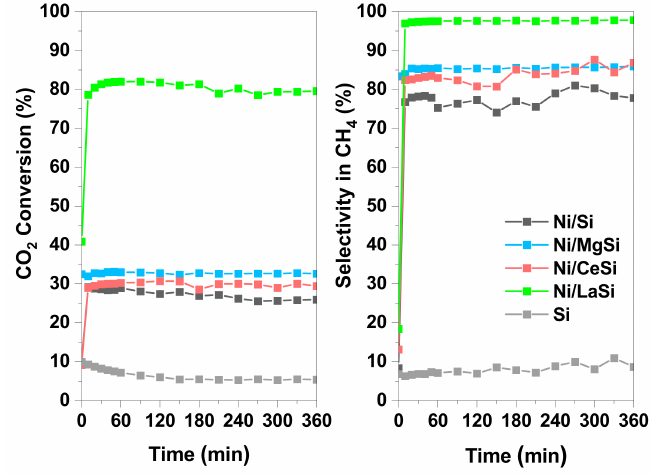
Figure 8. CO 2 conversion and CH 4 selectivity for silica supported Ni catalysts in stability tests at 250 ◦ C (0.1 g catalyst, 1 atm, total gas flow 31 mL/min, C CO2 = 6.6%, CO 2 :H 2 = 1:5.2; GHSV = 4650 h − 1 ).